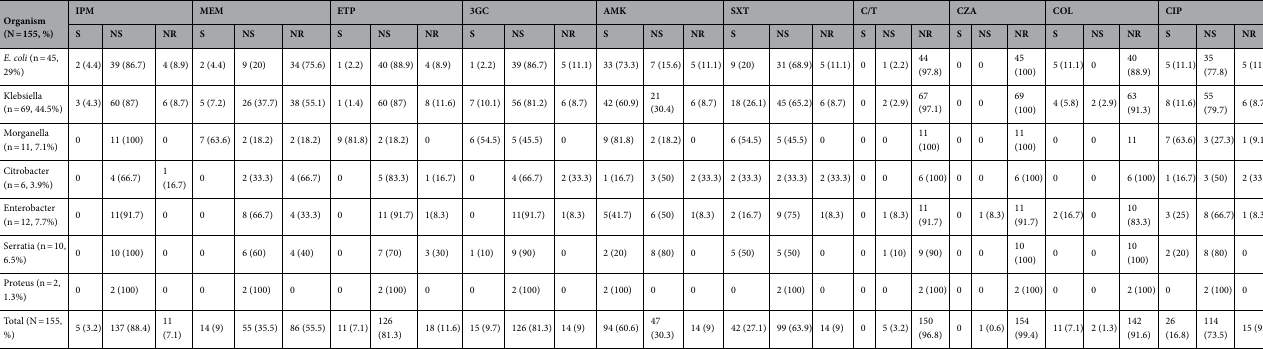
Table 3. Comparison of antibiotic susceptibility between different carbapenem-resistant Enterobacterales species. 3GC 3rd generation cephalosporins, AMK amikacin, C/T ceftolozane/tazobactam, CIP ciprofloxacin, COL colistin, CZA ceftazidime/avibactam, ETP ertapenem, IPM imipenem, MEM meropenem, NR not reported, NS non-susceptible, S susceptible, SXT sulfamethoxazole/trimethoprim.